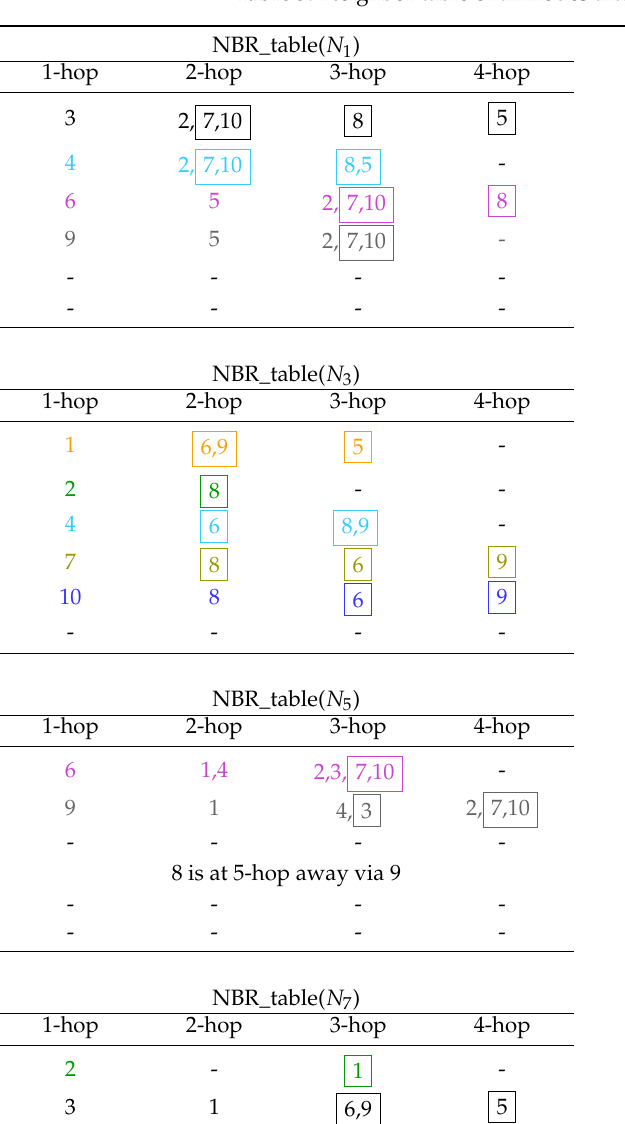
Table 3. Neighbor table of all nodes after completion of neighbor discovery